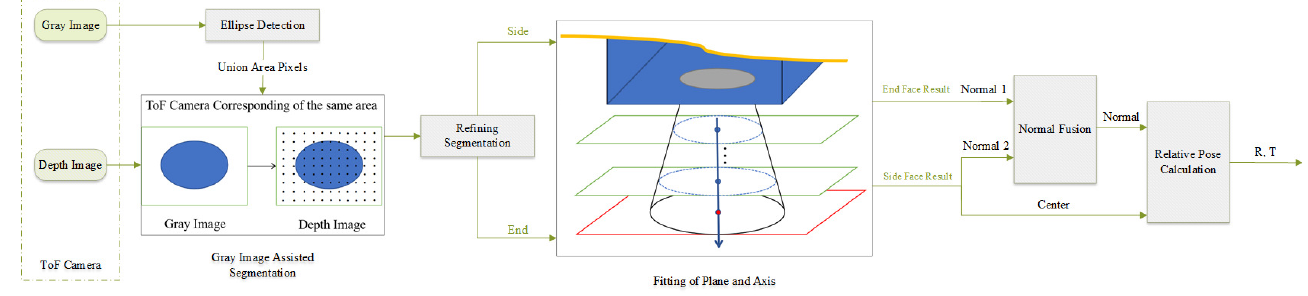
Figure 3. Illustration of coordinate frames and related vectors.